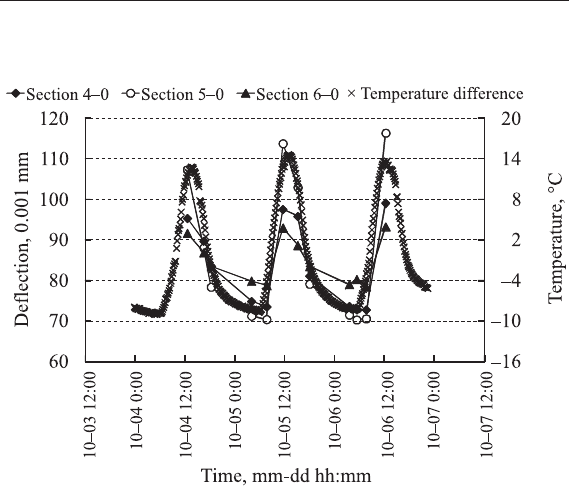
Fig. 3. Deflection of slab center measured at loading